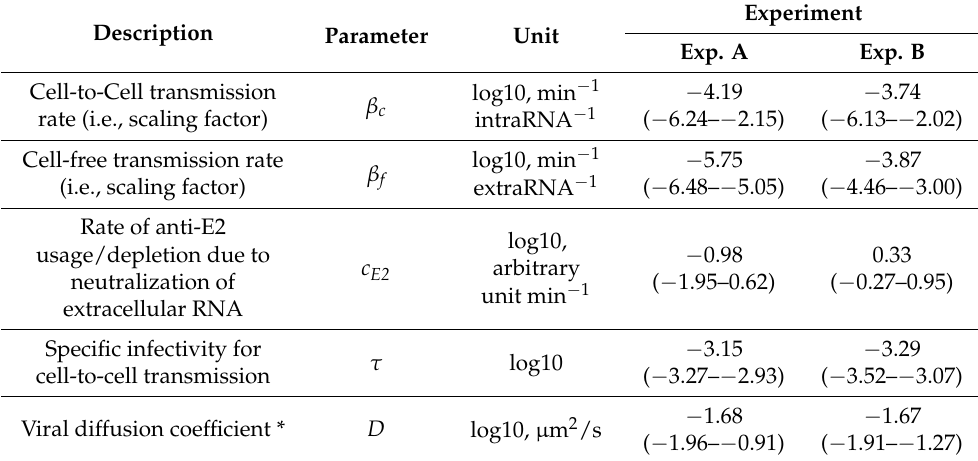
Table 1. Estimates of parameters describing HCV spread within the different experiments: The estimate indicates for each experiment the weighted mean out of all parameter combinations obtained after 15 (Exp. A) and 13 (Exp. B) generations of optimizations by pyABC (see Section 2). Numbers in brackets indicate 95% credibility intervals. (* The theoretically derived diffusion coefficient D according to the Stokes-Einstein equation is D = 8.05 µ m 2 /s (=0.91 on a log10 scale) according to the assumed diameter of a hepatocyte (20 µ m), of an HCV virion (30 nm) and the dynamic viscosity of the medium. The estimated diffusion is much slower than the theoretical prediction as it represents the effective diffusion allowing exported virions to reach uninfected cells in the